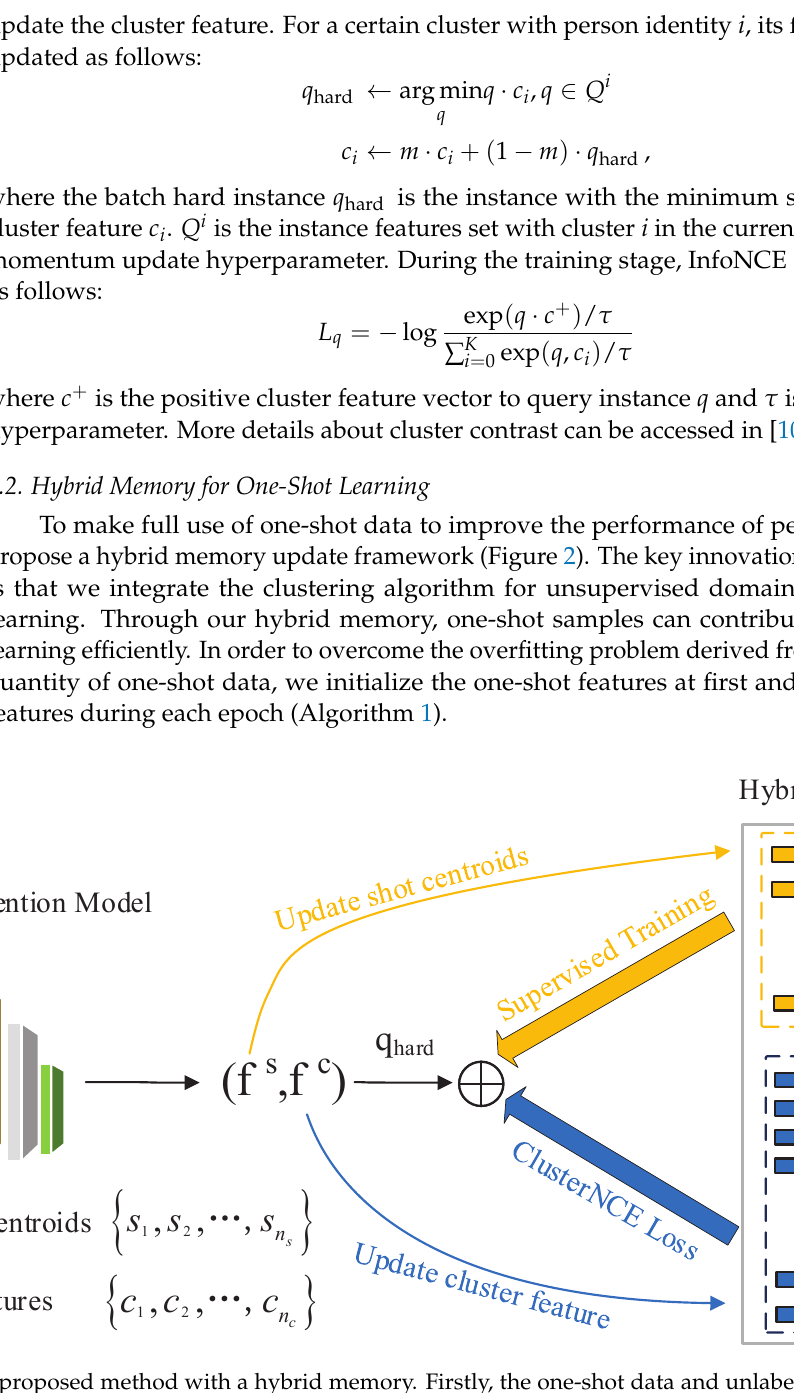
Figure 2. Framework of our proposed method with a hybrid memory. Firstly, the one-shot data and unlabeled data are initialized by our deep attention module. Secondly, the one-shot data class centers and unlabeled data cluster features are sent to the hybrid memory. Then, we train the one-shot data features and cluster features jointly with hard instance features. Finally, we dynamically update the features of our hybrid